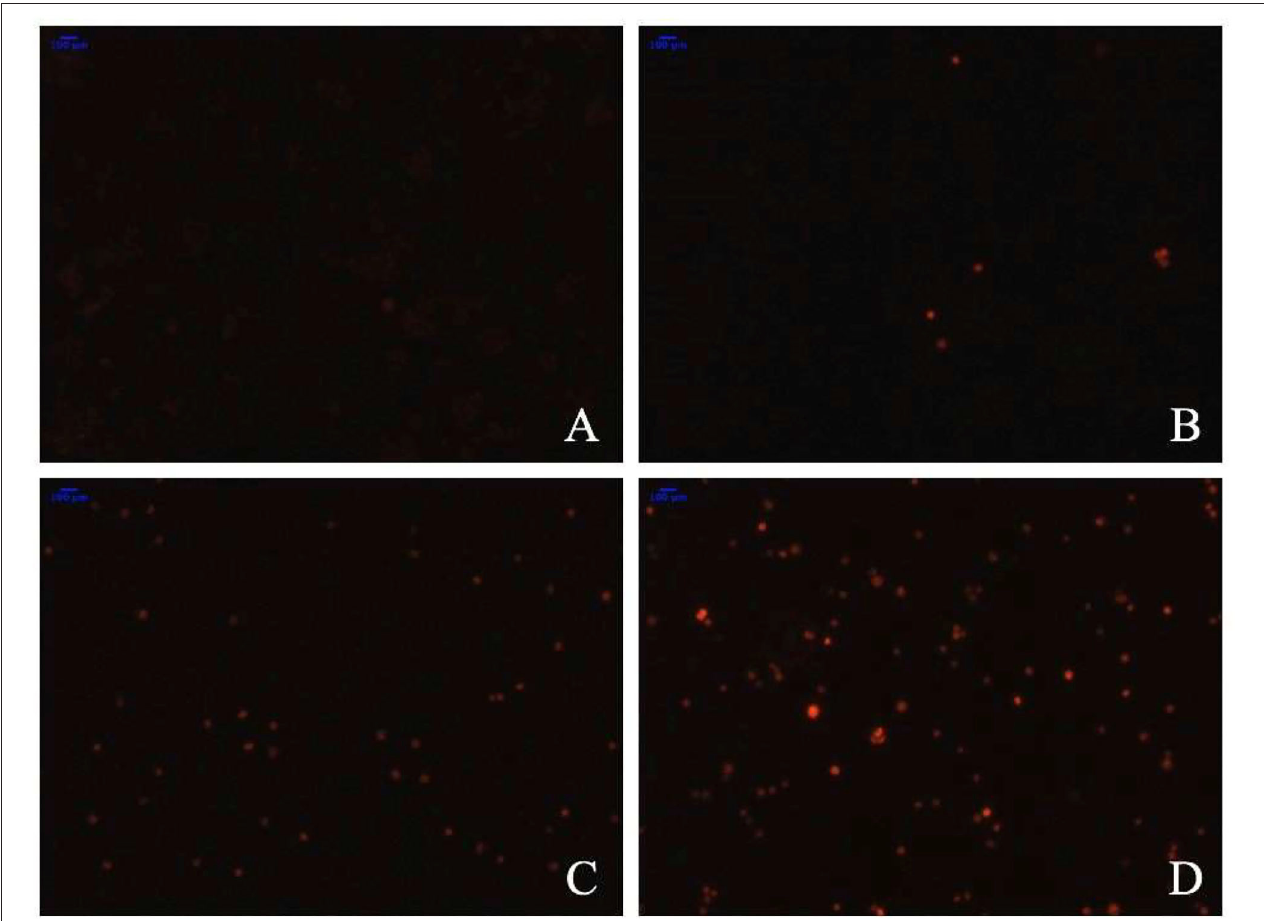
FIGURE 8 | Effect of TBs-E on cell apoptosis (200X); (A) control, (B) TBs-E treatment (24h), (C) TBs-E treatment (48h), and (D) TBs-E treatment (72h).